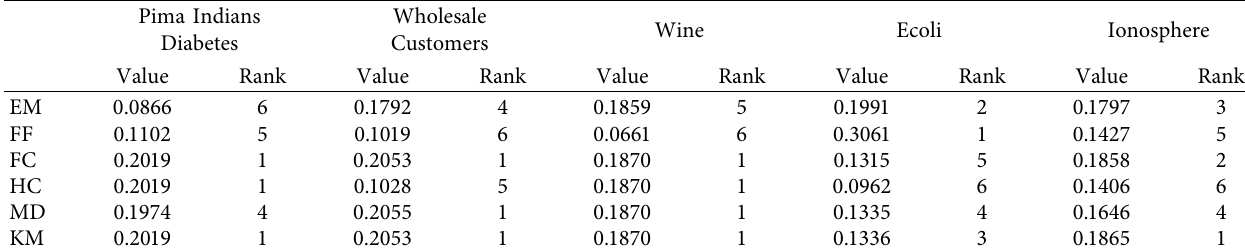
Table 6: Rankings of TOPSIS for the five assigned UCI data sets.